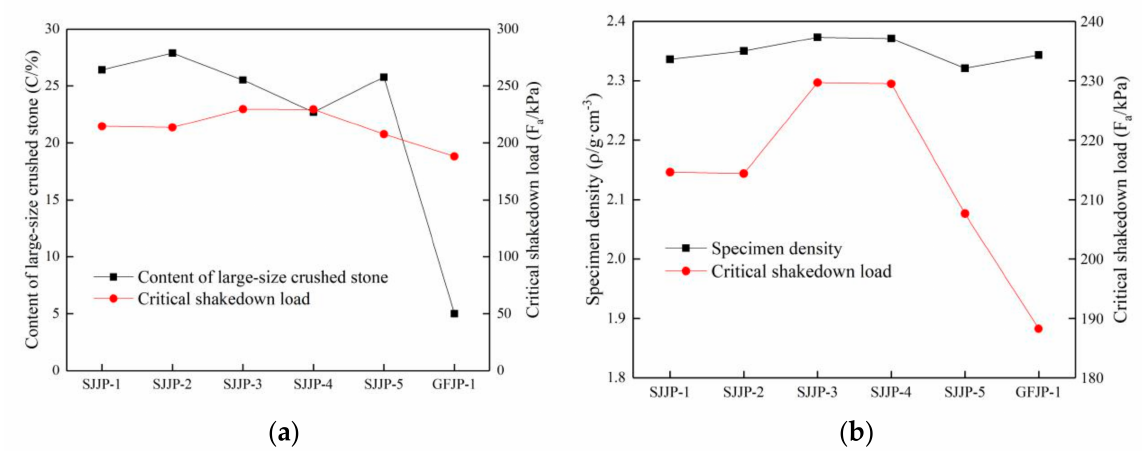
Figure 13. ( a ) Relationship between critical shakedown load and content of large-size crushed stone; ( b ) relationship between critical shakedown load and specimen density.